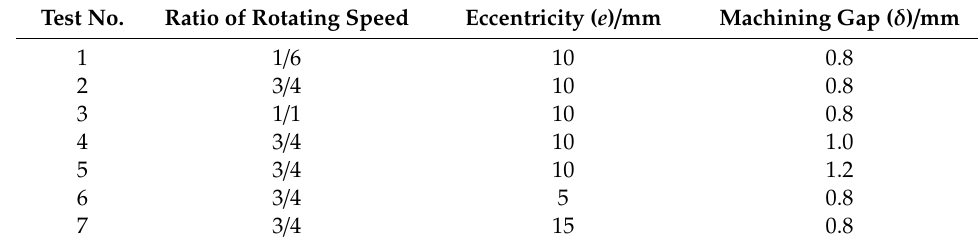
Table 7. Finishing parameters in the simulation.